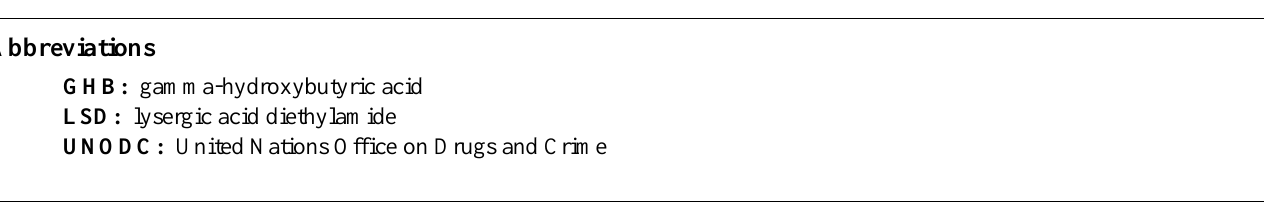
UNODC: United Nations Office on Drugs and